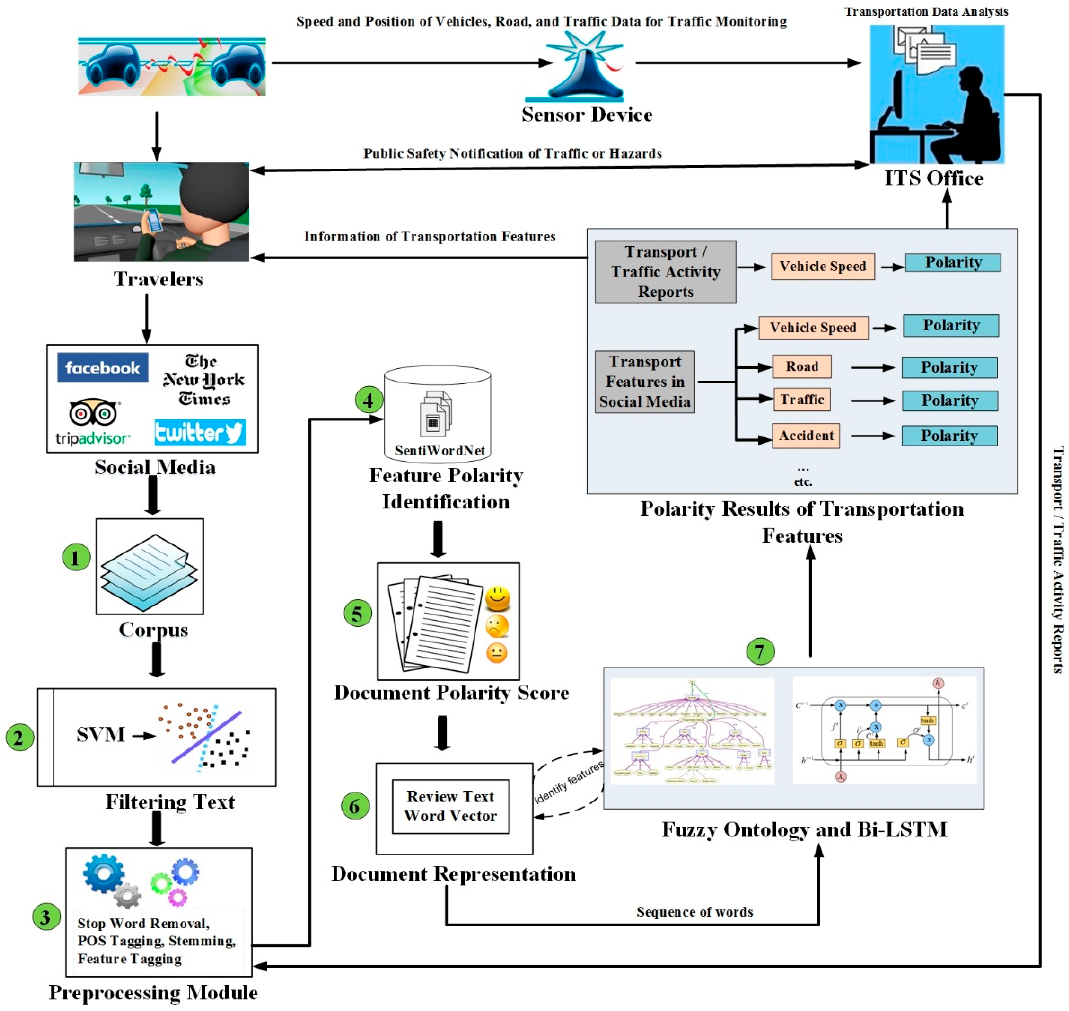
Figure 1. Proposed system architecture.